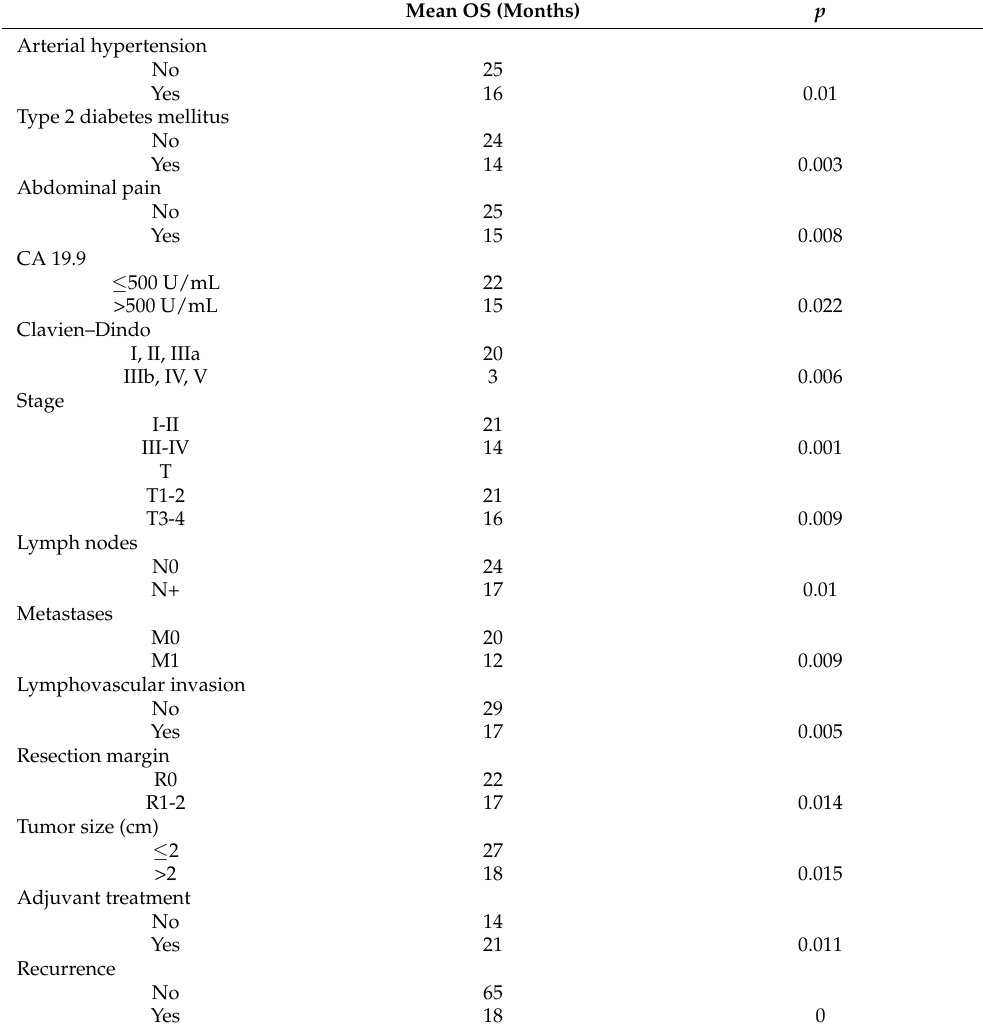
Table 1. Variables influencing overall survival. Abbreviations—CA 19.9: carbohydrate antigen 19.9; T: tumor.